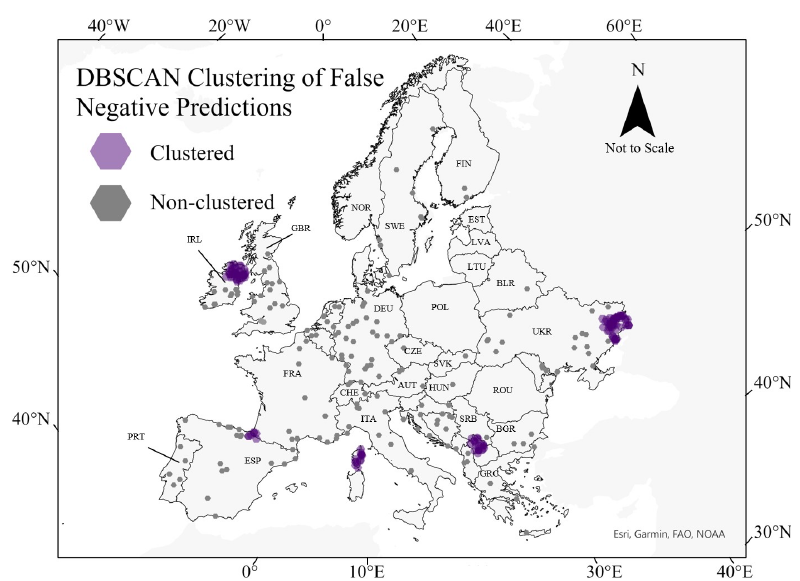
Figure 5. DBSCAN false negative clusters (purple). Clustering is occurring within Northern Ireland, Northern Spain, Eastern Ukraine, Kosovo, and Corsica, France. Each region has the following attribute in common: large-scale and ongoing separatist terrorism. Thus, suggesting a common spatial attribute among territorial terrorism separate from non-territorial. Note, clusters were enlarged for visualization purposes and are therefore not to scale. The map is in the Albers equal- area conic projection system.